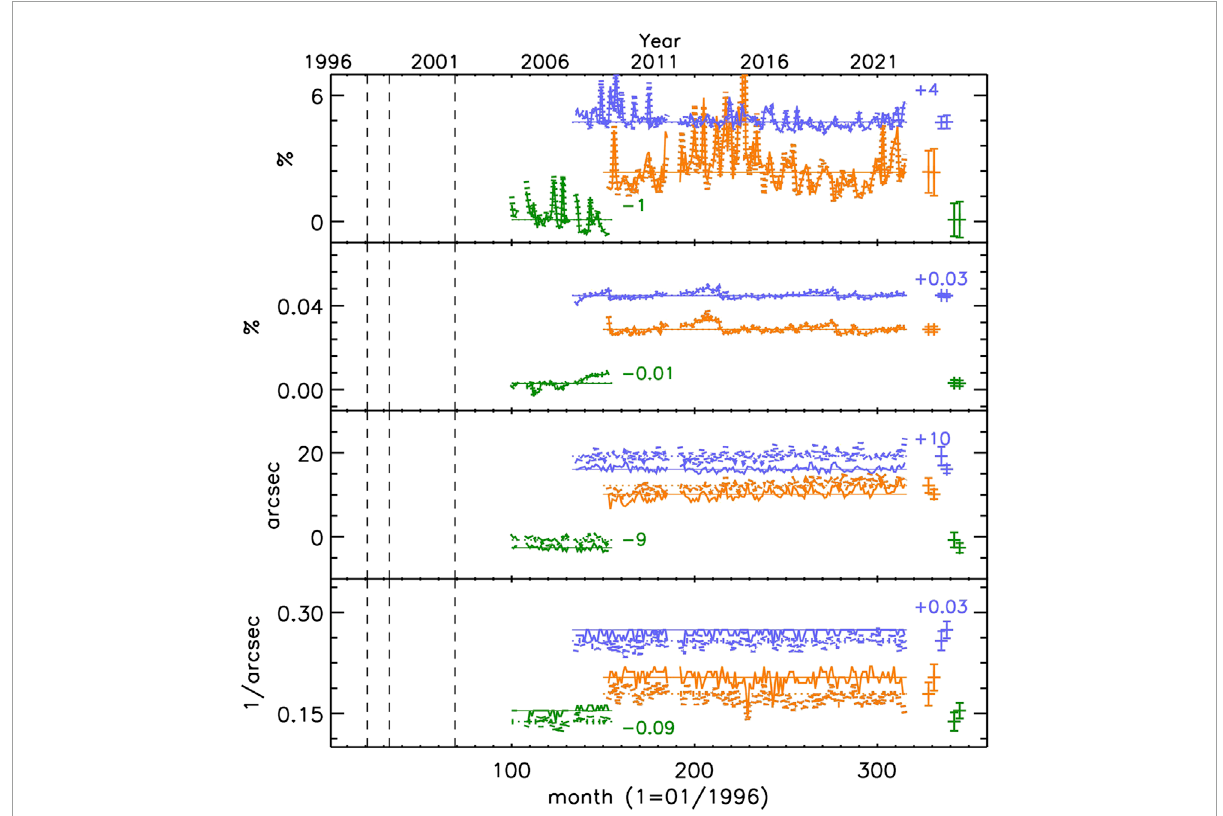
FIGURE 10 Same as Figure 9 but for observations taken with the Ca II K narrower band (KN; orange line), green continuum (G; green line), and G-band (C; violet line) filters. Vertical dashed lines mark times of instrumental discontinuities. Horizontal dashed and solid lines show the mean of the values measured on sum of 25 exposures and single exposure observations, respectively. For the sake of clarity, G and C data are shifted by the values specified in each